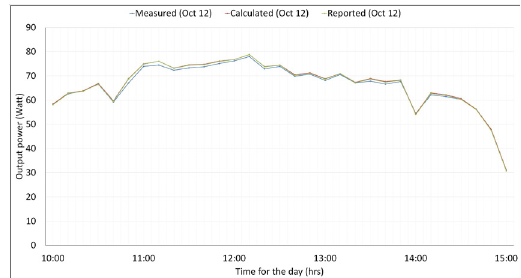
Figure 1. Outdoor test set up of a-Si / thin film PV technology module at NISE, Gurgaon, India [2]. Table 1: Calculated coe ffi cients and their RMSE, along with coe ffi cients of reported model [3].